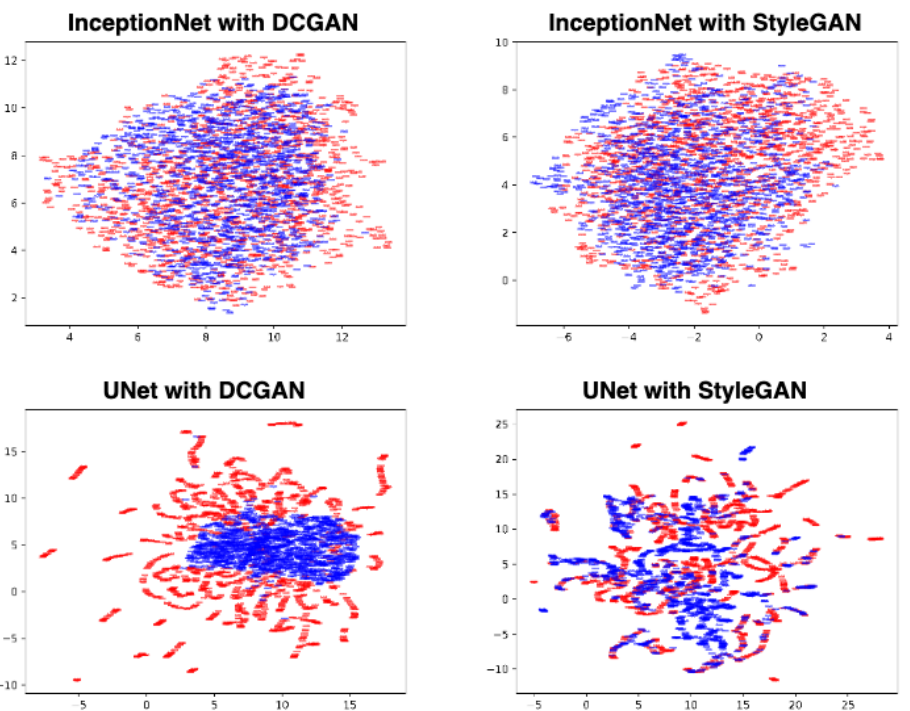
Figure 7. Comparison of UMap projection of activations of images generated by a DCGAN, and others generated by a StyleGAN, with an InceptionNet trained on ImageNet ( top row ), and a U-Net trained on the original dataset ( bottom row ). Red points: real images; blue points: generated